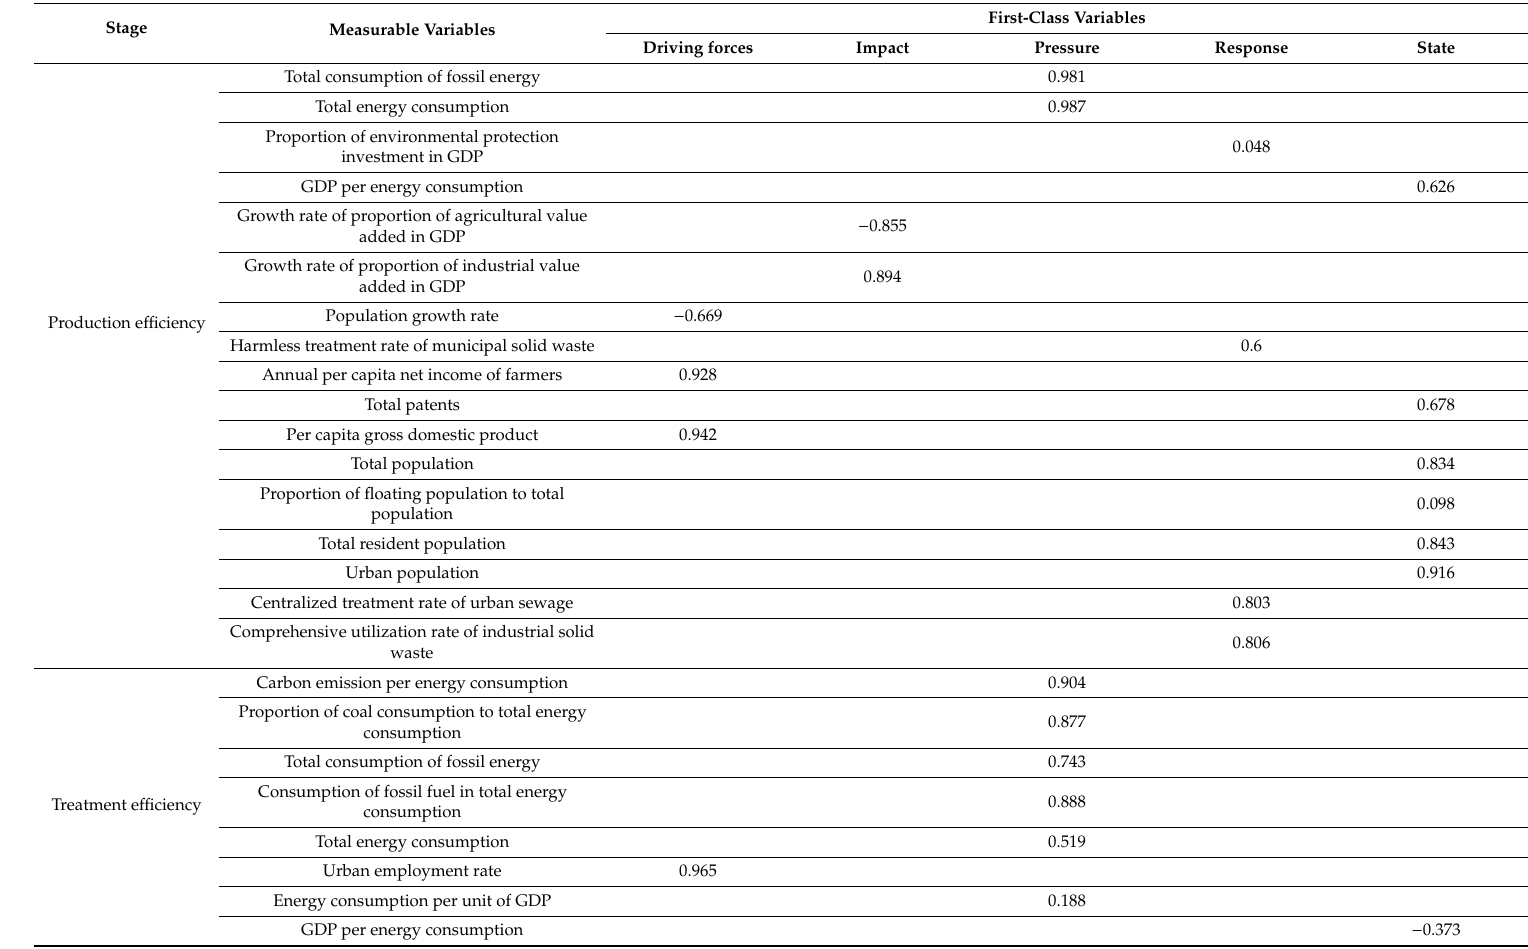
Table 4. External load